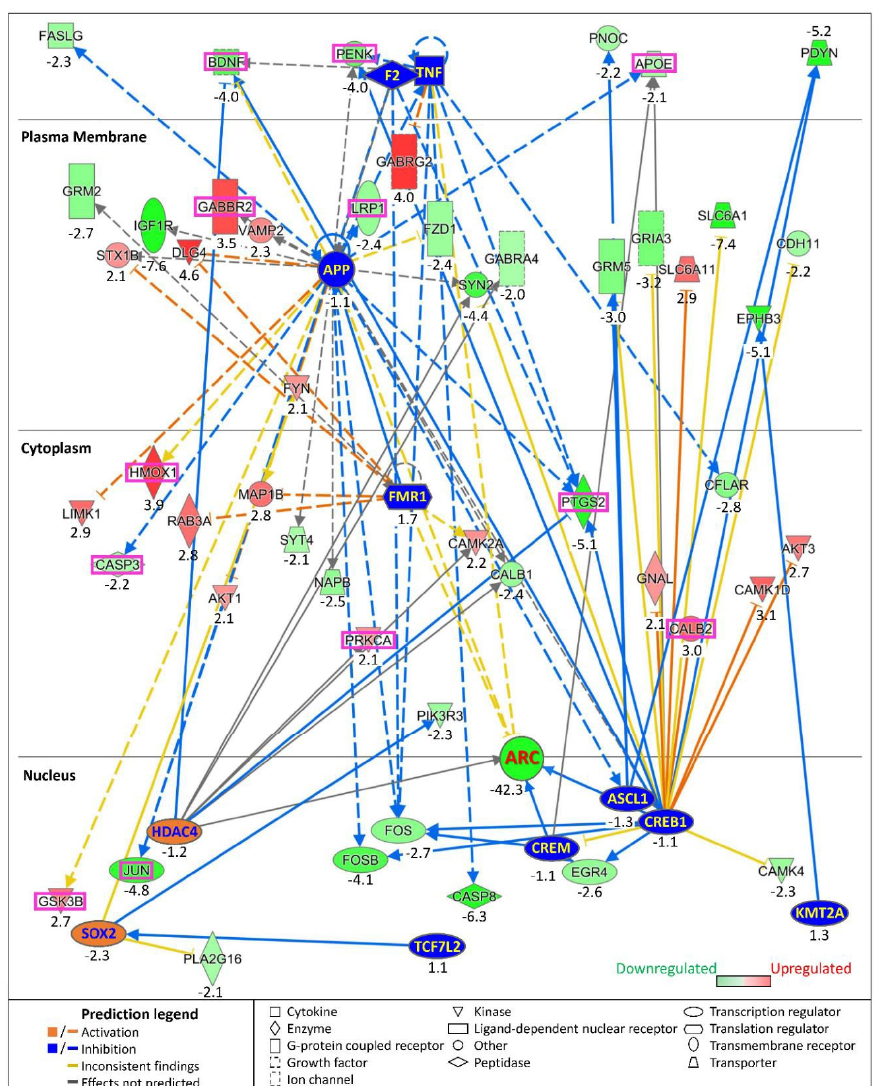
Figure 18. Upstream regulators of differential gene expression caused by Arc knockdown. The map shows 11 upstream regulators (blue and orange boxes) predicted by IPA to mediate altered gene expression upon Arc knockdown. Genes are positioned in the extracellular space, the plasma membrane, the cytosol, or the nucleus, depending on where their associated proteins are located. Arc was positioned at the interface of nucleus and cytoplasm because it can be in either compartment. Only genes that were involved in the following pathways and disease annotations are shown: (i) opioid signalling, (ii) synaptogenesis, (iii) endocannabinoid neuronal synapse pathway, (iv) synaptic LTD, (v) neuroinflammation, (vi) CNS amyloidosis, (vii) tauopathy and (viii) AD. Genes associated with disease annotations are boxed in magenta. The respective fold changes are indicated below each